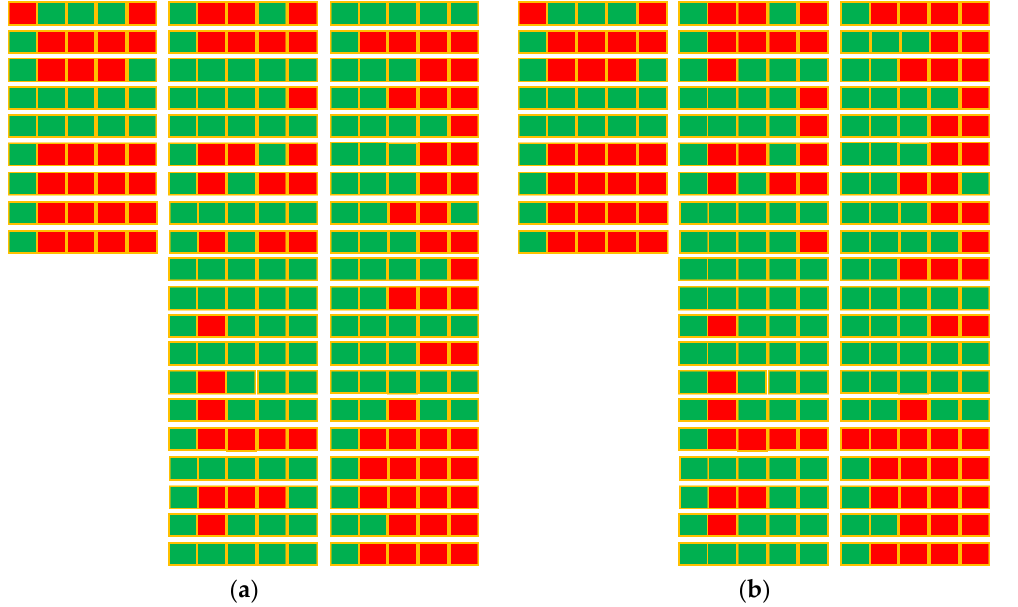
Figure 7. Schematic representation of the study area highlighting the samples selected by the pro- posed active learning technique. Each rectangle represents a plot. It is divided in 5 parts representing an acquisition date. If the part is colored in green, the sample is selected for regression. ( a ) Sampling schema for dry mass estimation. ( b ) Sampling schema for N-uptake estimation.